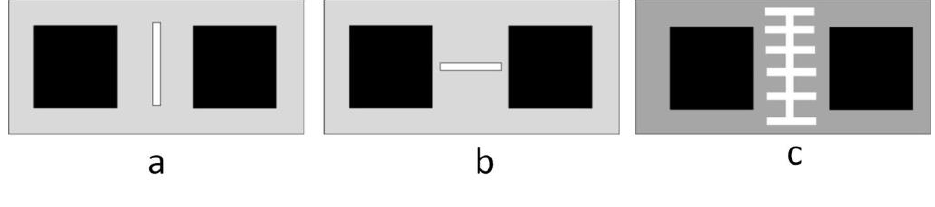
Fig. 5. Antennas with defects of dielectric substrate This type of substrate defect allows to increase the decoupling more than 11 dB at the requiered frequence (Fig. 6).